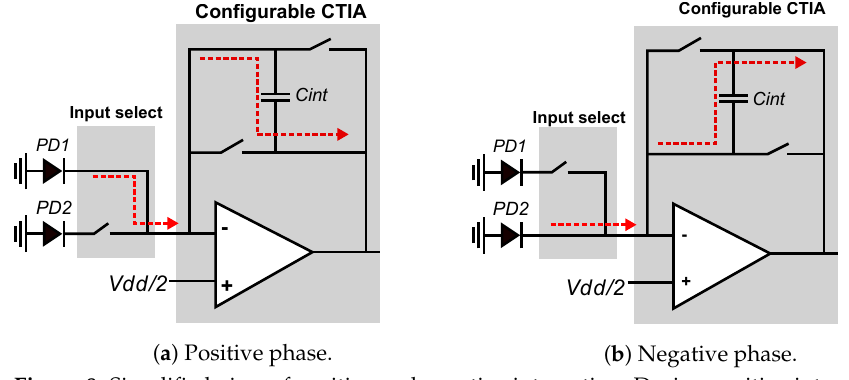
Figure 8. Simplified view of positive and negative integration. During positive integration: sw1 and sw4 stay closed, sw2 and sw3 stay open. During positive integration: sw2 and sw3 stay closed, sw1 and sw4 stay